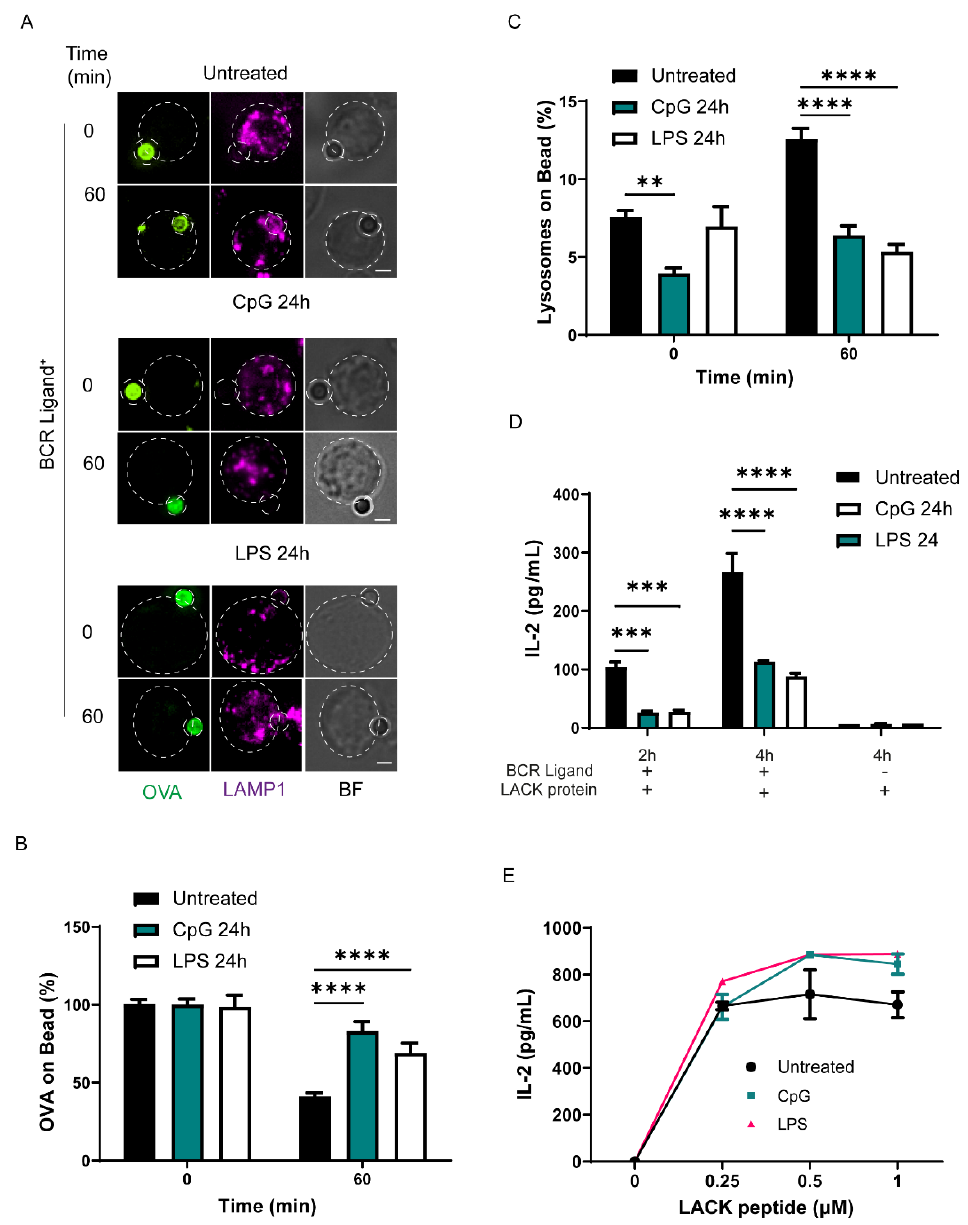
Figure 1. Treatment with CpG and LPS decrease antigen extraction and presentation by B cells. ( A ) Representative images of control, CpG and LPS pre-treated B cells incubated with beads coated with OVA and a BCR ligand+ (anti-IgG) in resting (0 min) and activated (60 min) conditions. Cells were fixed and stained for OVA (green) and LAMP-1 (magenta). BF: Bright Field. Images are shown as Z-projections of a stack. Scale bar = 3 µm. N = 3 ( B ) Quantification of OVA fluorescence remaining on the bead, normalized by initial fluorescence. *** p < 0.001, **** p < 0.0001. N = 3. (>90 cells). Two-way ANOVA with Sidak’s multiple comparison test. ( C ) Quantification of lysosome accumulation at the IS. ** p < 0.01, **** p < 0.0001. N = 3. (>90 cells). Two-way ANOVA with Sidak’s multiple comparison test. ( D ) Antigen presentation assay of control, CpG or LPS pre-treated B cells. Levels of IL-2 secretion by T cells were quantified by ELISA, *** p < 0.001 **** p < 0.0001. N = 3. Two-way ANOVA with Sidak’s multiple comparison test. ( E ) Representative graph of peptide controls for cells used in antigen presentation assays.